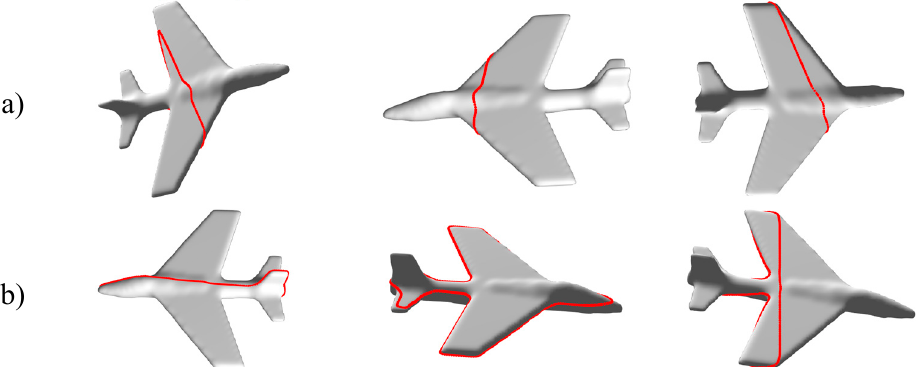
Figure 5. ( a ) Examples of blind contour following paths for model of Plane. ( b ) Examples of guided contour following paths by visually interesting points for model of Plane.